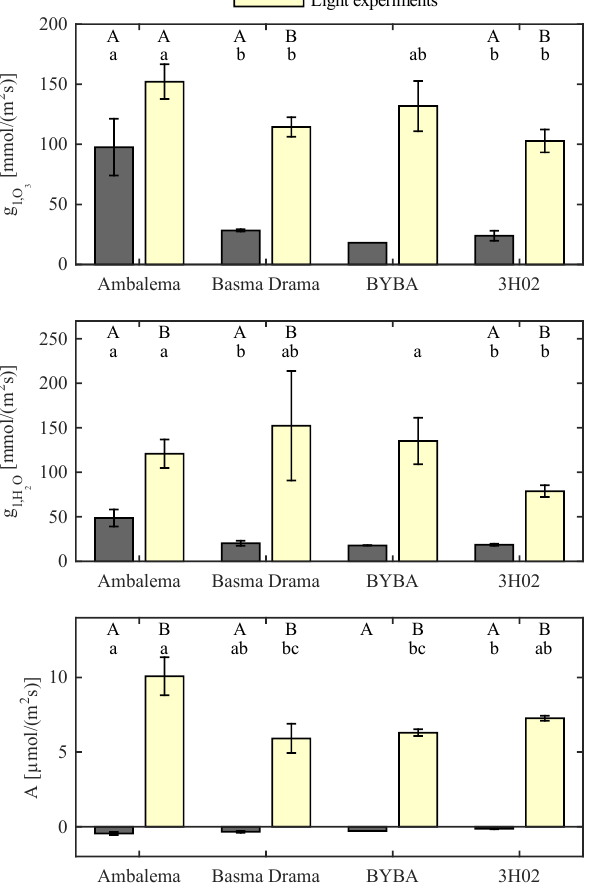
Figure 4. Total ozone conductance g l , O (top), total water vapour 3 conductance g l , H (middle) and assimilation rates A (bottom) of 2 O different tobacco varieties during dark and light conditions. Error bars denote the standard error of 5 (13), 2 (6), 1 (5) and 3 (5) repli- cates of Ambalema , Basma Drama , BYBA respectively 3H02 in dark (light) experiments. Different capital letters denote significant dif- ferent means in light and dark experiments of the same plant type and lower case letters significant different means of different plant types in either dark or light experiments, respectively (Wilcoxon- Mann-Whitney test, p < 0.1, see Sect. 2.9. Lacking replicates in the statistical analysis dark experiments using BYBA plants were omit- ted). Under dark conditions stomatal ozone conductance is gener- ally low and consequently surface reactions are the major ozone sink. The surface sink is high for the Ambalema tobacco line, which exudes cis -abienol and lower for the other lines, exuding less reac- tive or no